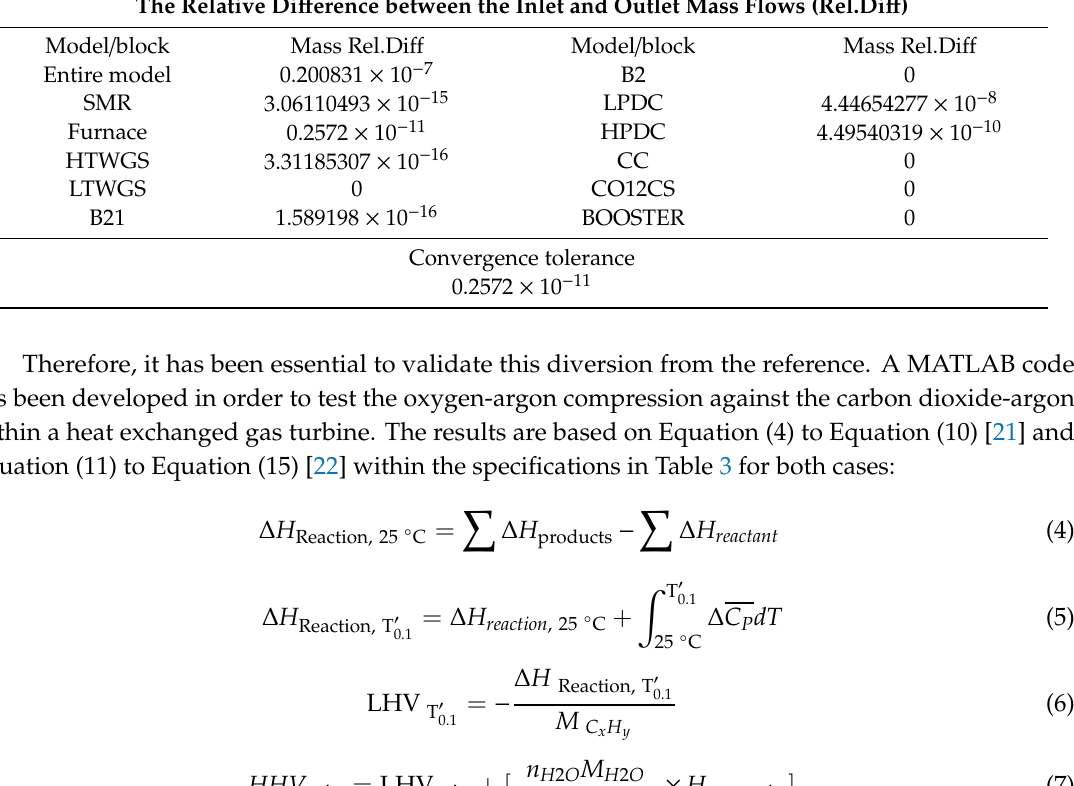
Table 1. Mass balance of the ASU-SMR-WGS-PSA-CCS-HXGT (CARSOXY) model. The Relative Di ff erence between the Inlet and Outlet Mass Flows (Rel.Di ff